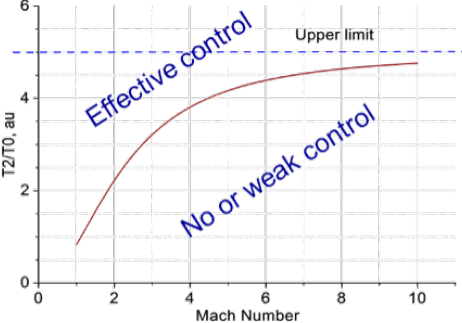
Figure 12. Simplified criteria of plasma control of SW